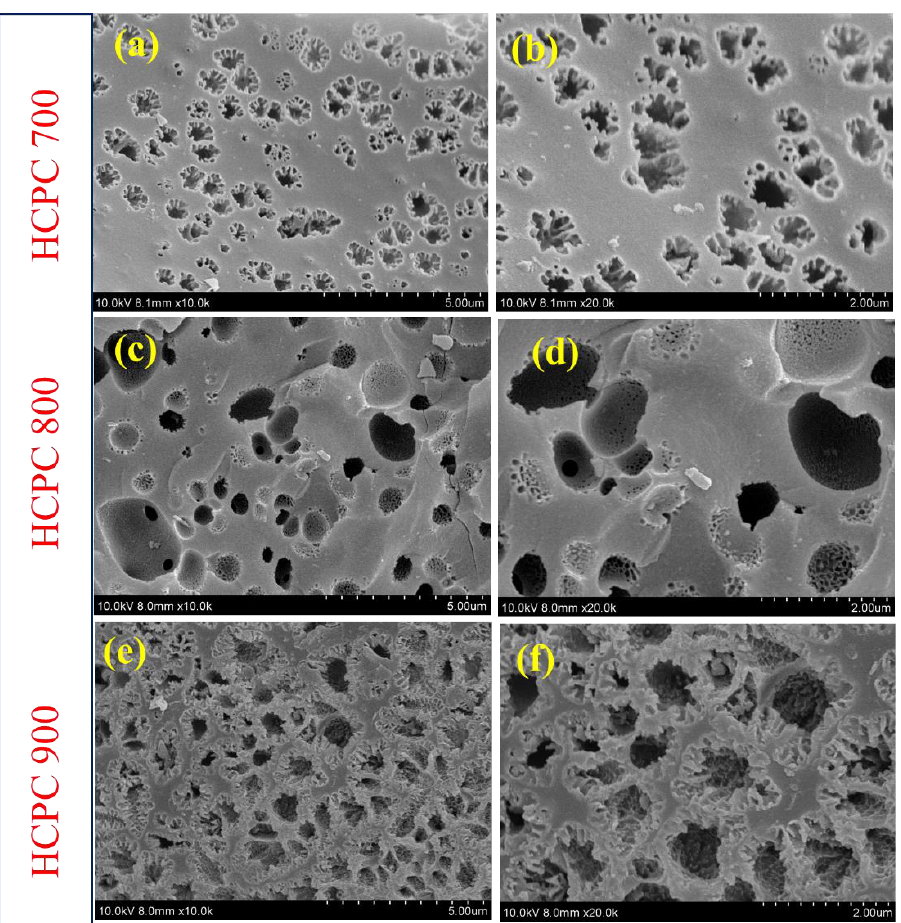
Figure 4. SEM images of ( a , b ) HCPC-700, ( c , d ) HCPC-800 and ( e , f ) HCPC-900.